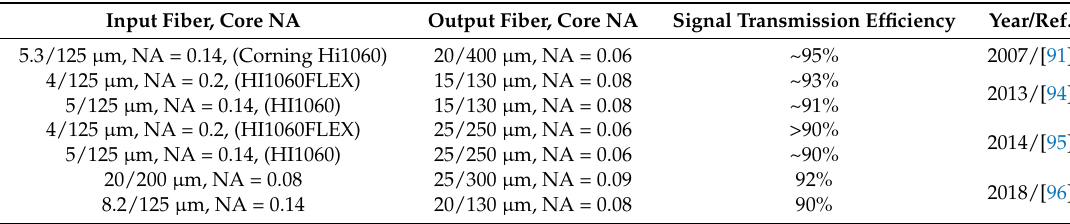
Table 4. Summary of recently reported mode field adaptors